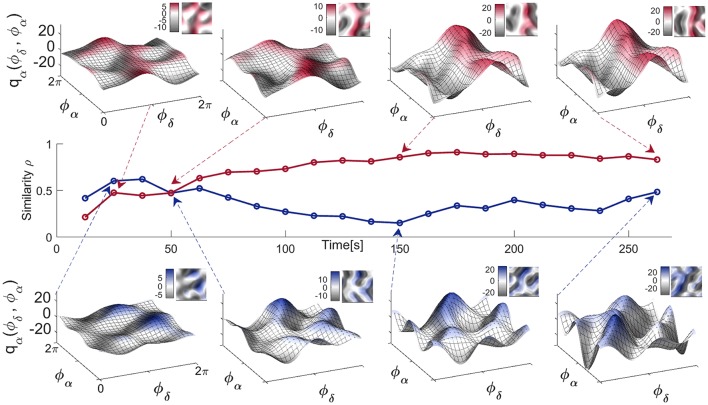
Time-evolution of the δ-to-α coupling functions in the resting state. Middle panel: Time-evolution of the similarity index ρα(δ, α) for the EO and EC states of a single representative subject. Top panel: The δ-to-α coupling functions for EC inferred at four particular moments in time, as indicated by the arrows. Bottom panel: The δ-to-α coupling functions for EO inferred at four particular moments in time. Complementary 2D color-contour plots of the coupling functions are given in the top right-hand corner of their respective panels.